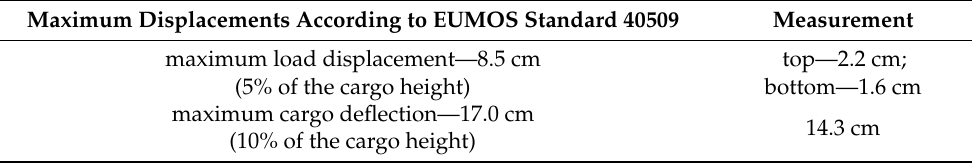
Table 8. Cargo displacement parameters during the 0.5 g acceleration test for non-standard foil. Maximum Displacements According to EUMOS Standard 40509